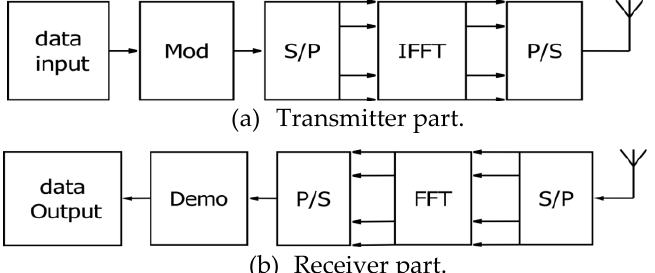
Figure 1. Orthogonal frequency division multiplexing (OFDM) systems. ( a ) Transmitter part; ( b ) Receiver part.